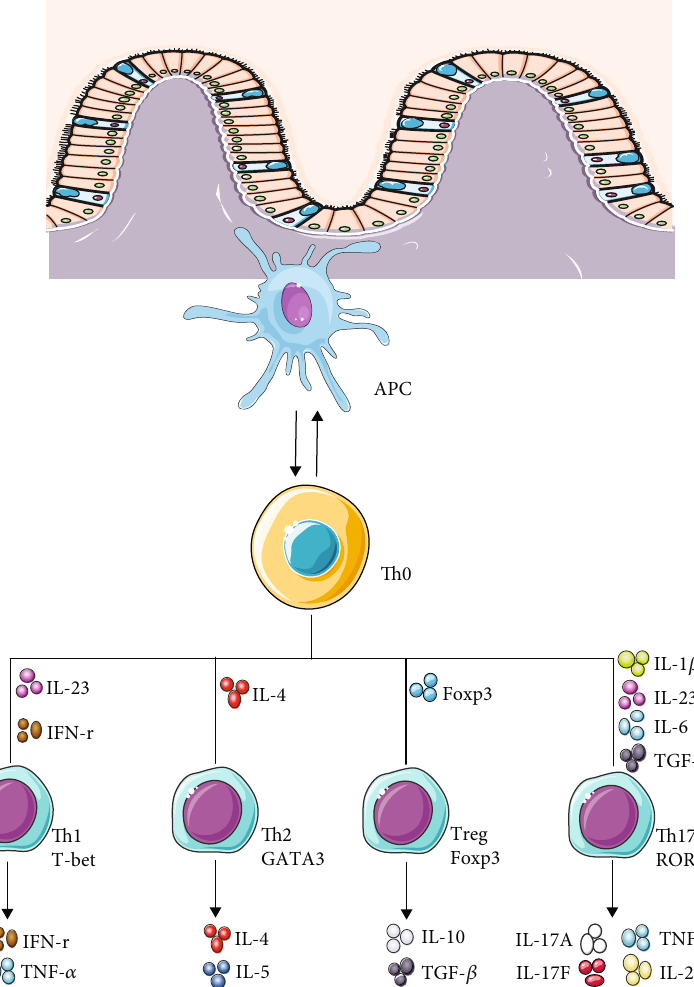
Figure 1: Di ff erentiation of Th17